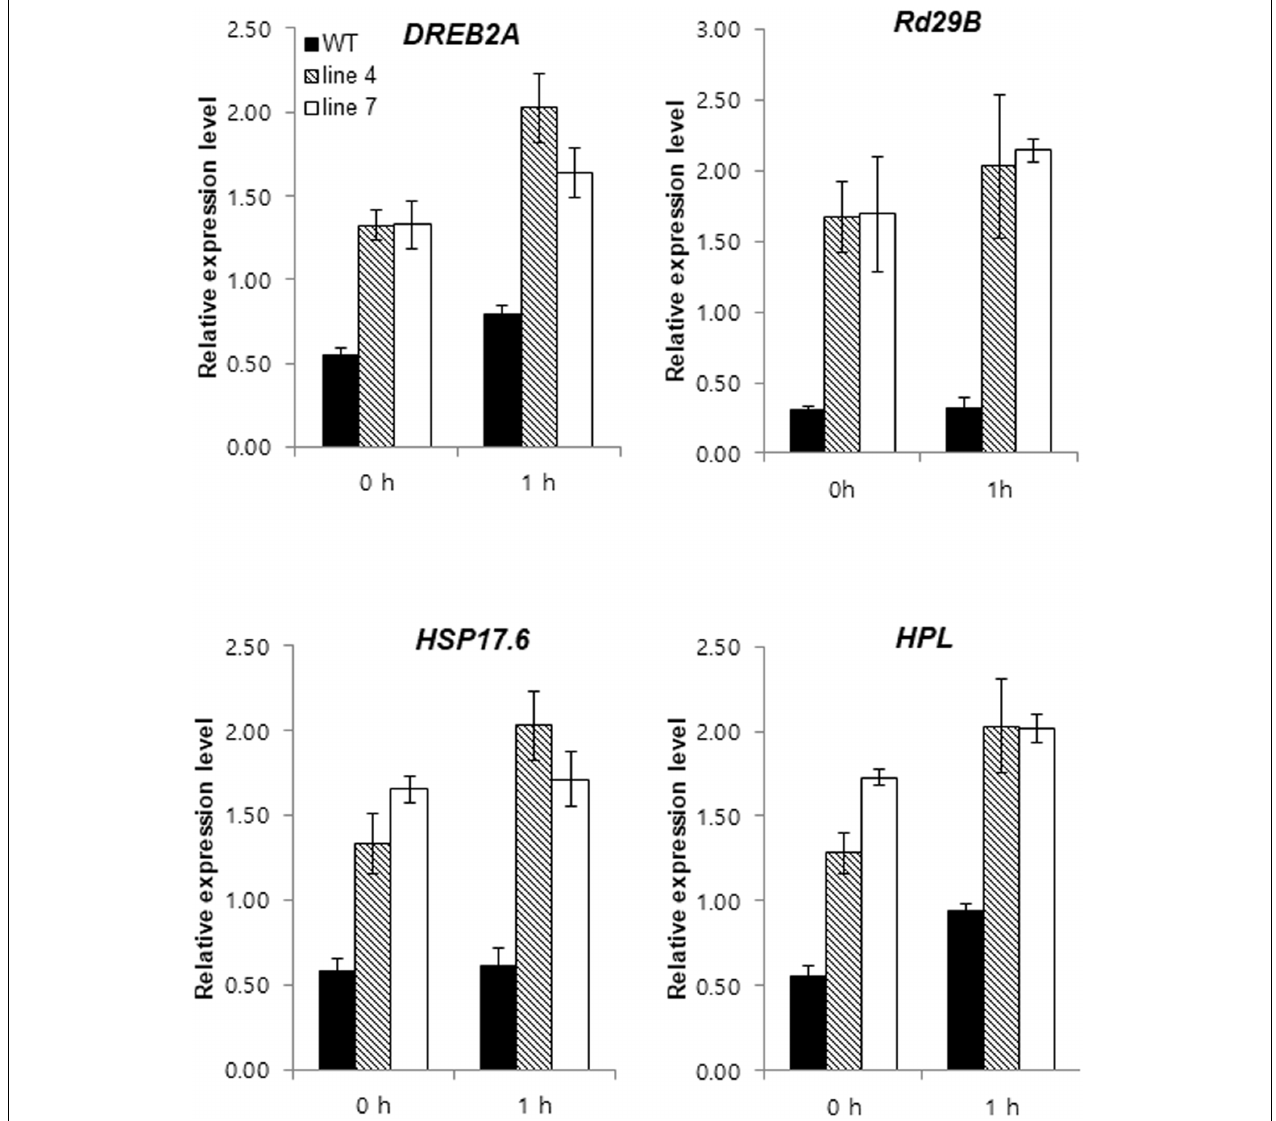
FIGURE 5 | Expression patterns of genes with known roles in abiotic stress responses in tobacco plants. Gene expression levels in WT and sysr1- transgenic leaves (Lines 4 and 7) were compared by qRT-PCR after 0 and 1 h of treatment with 300 mM NaCl. Error bars indicate the standard deviation of three technical replicates, and the results were consistent in two biological replicates. EF1 α was used as a reference gene. HPL , hydroperoxide lyase; DREB2A , dehydration-responsive element binding protein 2a; RD29B , responsive to desiccation 29 ; HSP17.6, heat shock protein